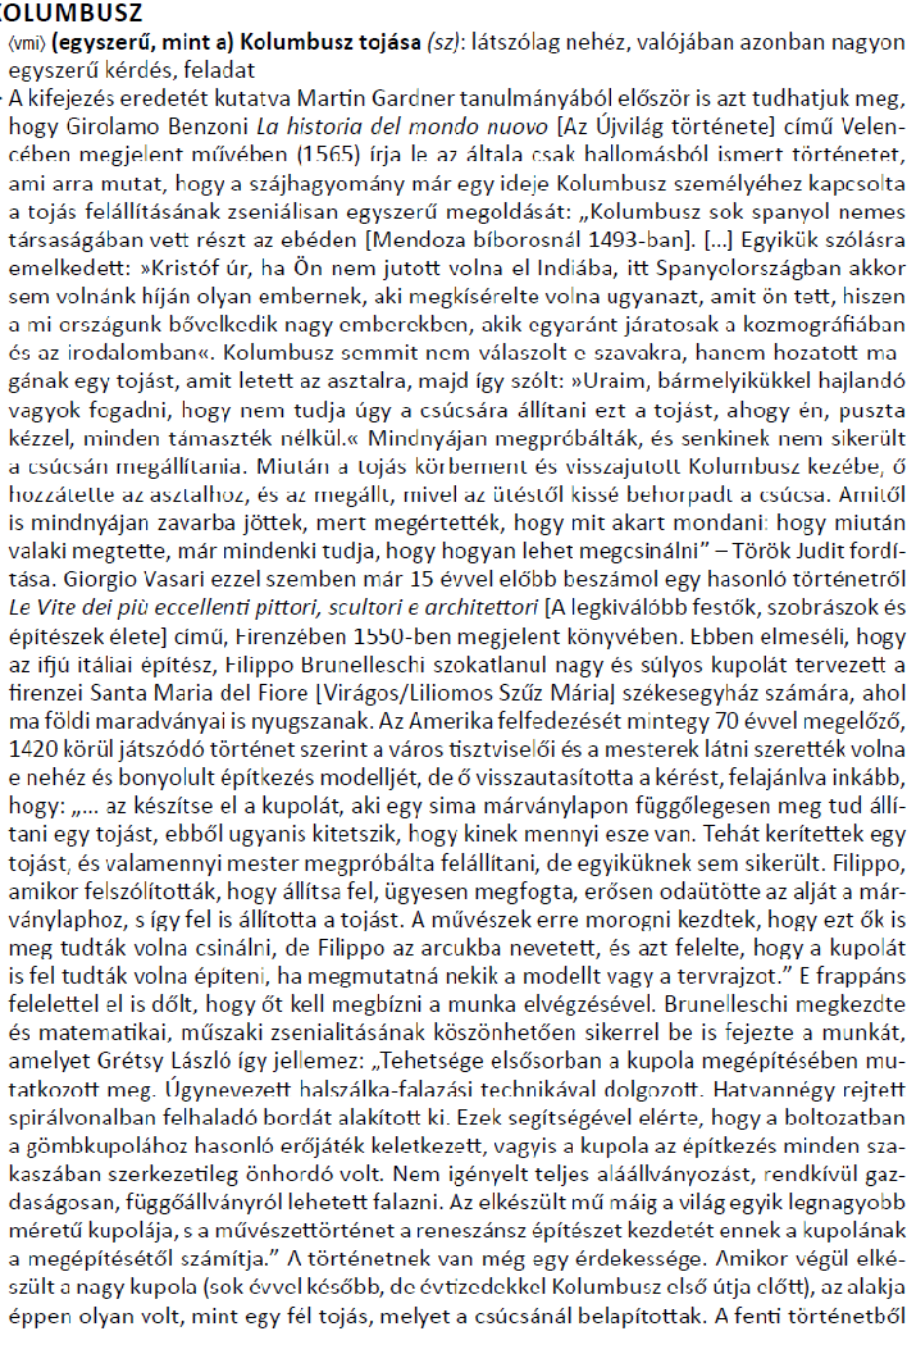
Figure 1: Explanation of origin of the saying the egg of Columbus (Bárdosi 2015, 297–298). Fig. 1 continued on next